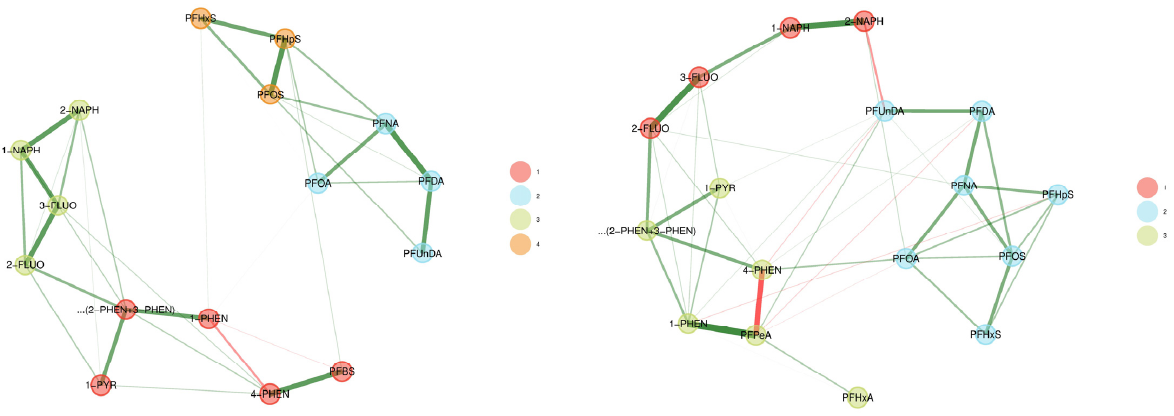
Figure 9. Weighted network for CELSPAC—FIREexpo firefighters ( left ) and the control group ( right ). The data were corrected for age and BMI. Urinary markers (OH-PAHs) were standardised for creatinine. Green lines represent positive associations while red signify negative associations between biomarker levels.